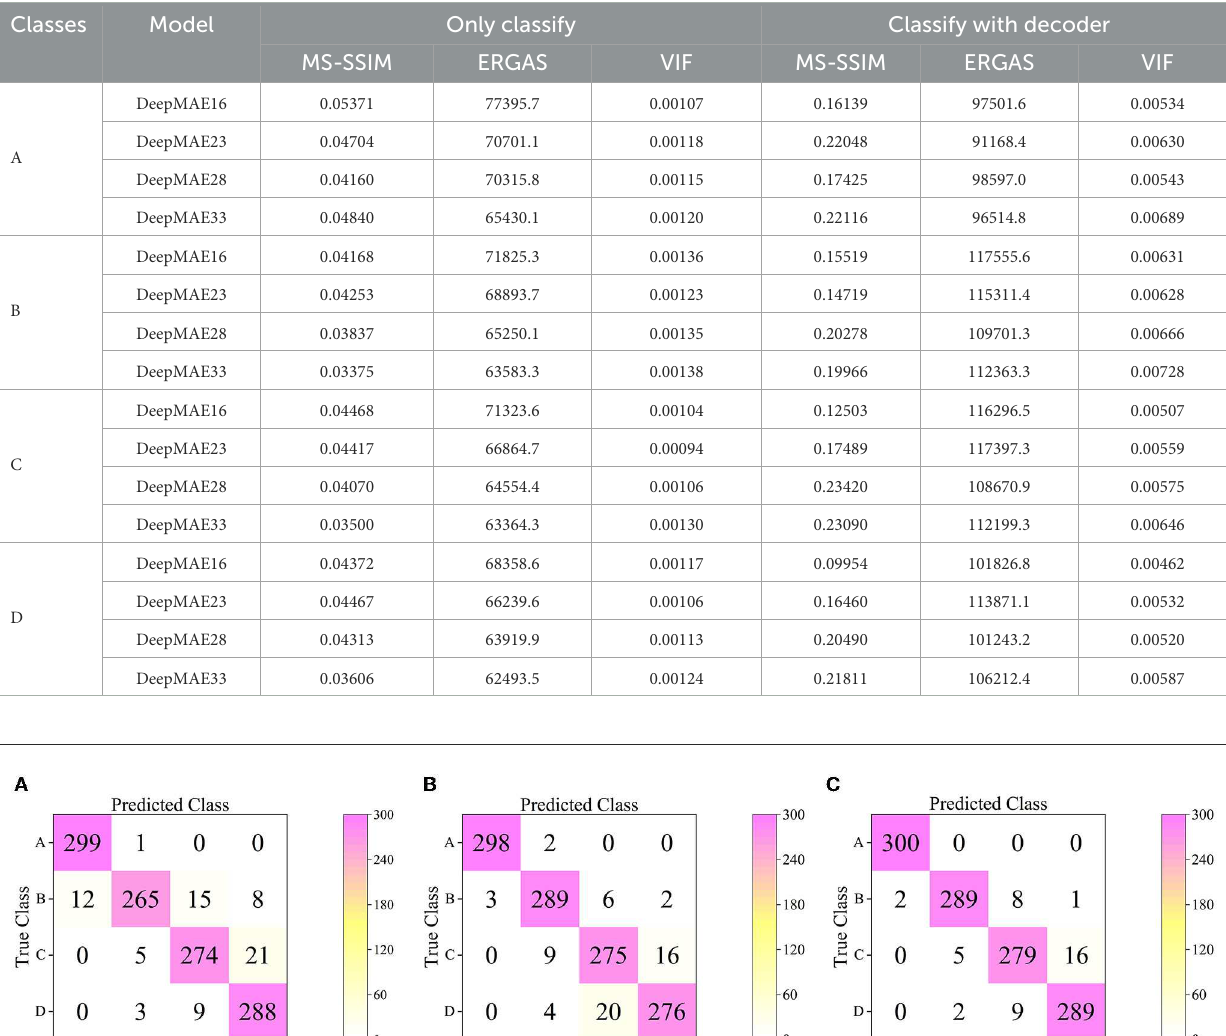
TABLE 5 On the comparison of “classification only” and “classification and feature reconstruction” to the quality of the reconstructed images.